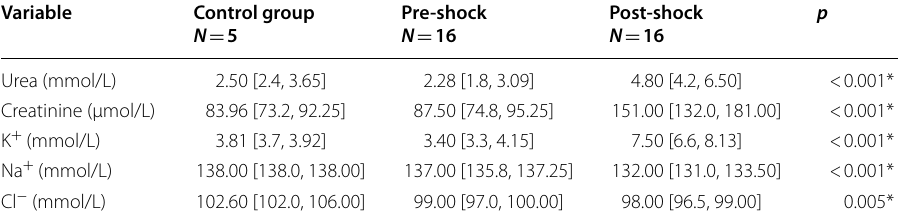
Data presented as Median [IQR]. p for Kruskal–Wallis rank‑sum test. *for statistically significant results ( p <